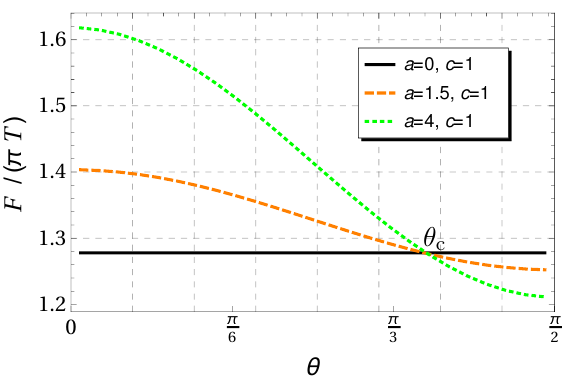
Figure 14 . We see that the e(cid:11)ect of a on the drag force depends on (cid:18) . (cid:18) c is a critical value where the drag force does not change at all.